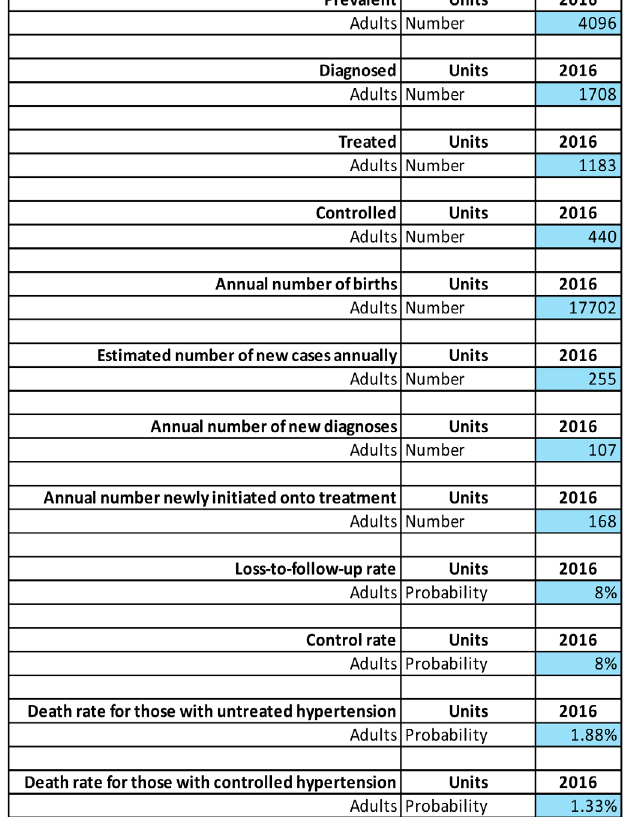
people are initiated onto treatment either immediately after diagnosis (with 20% of those diagnosed at pharmacies,